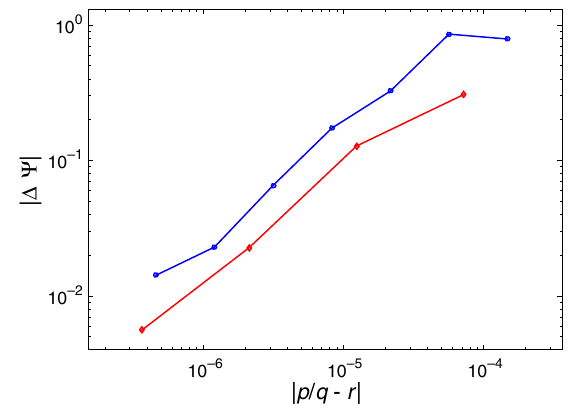
FIG. 9. Convergence of Floquet eigenfunctions for ω 1 = ω 2 ¼ p =q → r , where r is irrational [the golden mean, γ ¼ 1 . 6180 … ffiffiffi i i p 2 (blue line) and (orange line)]. Note that j ΔΨ j is calculated relative to the best rational approximation used ( 2584 = 1597 for γ ffiffiffi p 2 and 3363 = 2378 for ); it is approximately linear in j p=q − r j . Parameters of the Hamiltonian are described in the text.